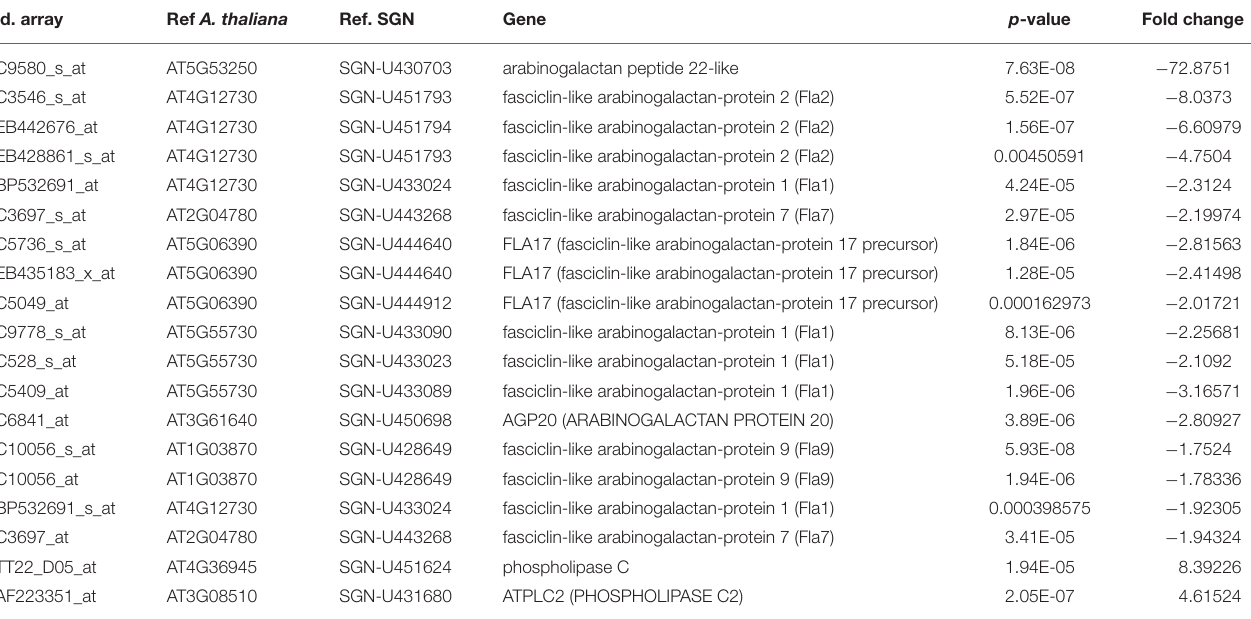
TABLE 1 | Differential expression of AGP and phospholipase C genes in salt adapted cells in comparison with control cells growing in the log phase. Id.